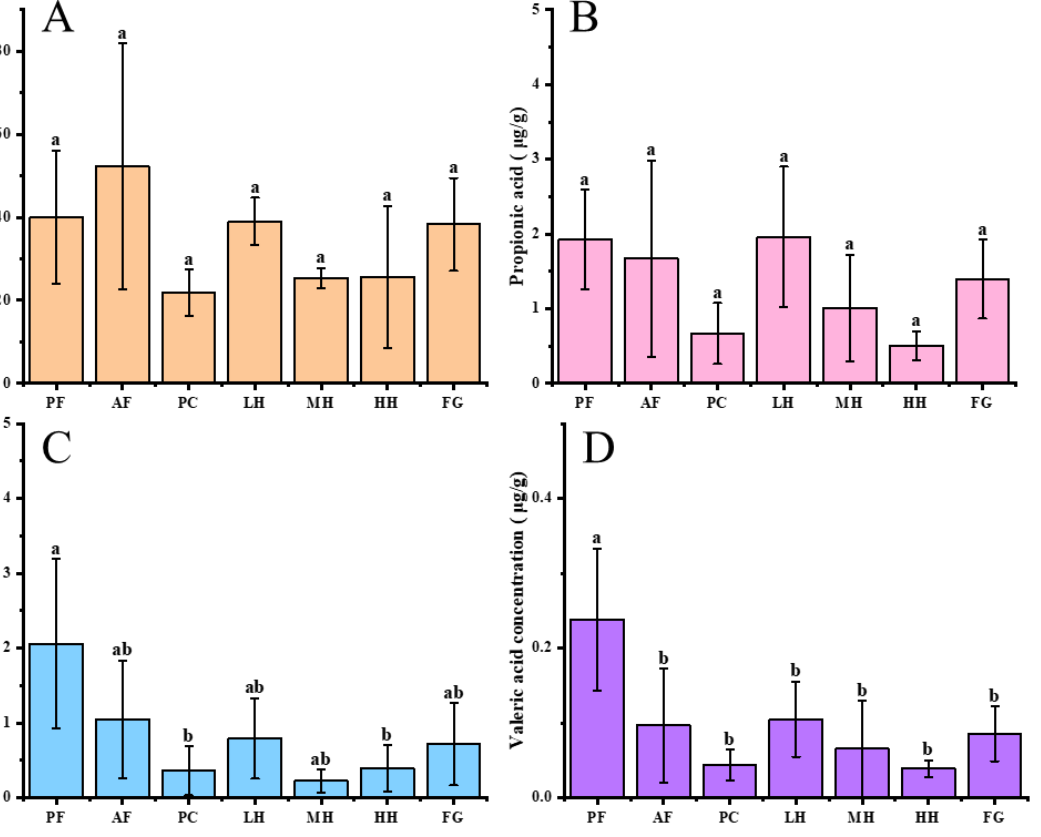
Figure 5. Concentration of SCFAs in the colonic contents of mice in each group. ( A ) Acetic acid. ( B ) Propionic acid. ( C ) Butyric acid. ( D ) Valeric acid. Different letters a and b represent the significant difference between groups ( p < 0.05). Note: PF represents the pair – fed control group. AF represents the alcohol – fed model group. PC represents the positive control group. LH represents the low – dose citrus honey group. MH represents the medium – dose citrus honey group. HH represents the high – dose citrus honey group. FG represents the fructose syrup group.